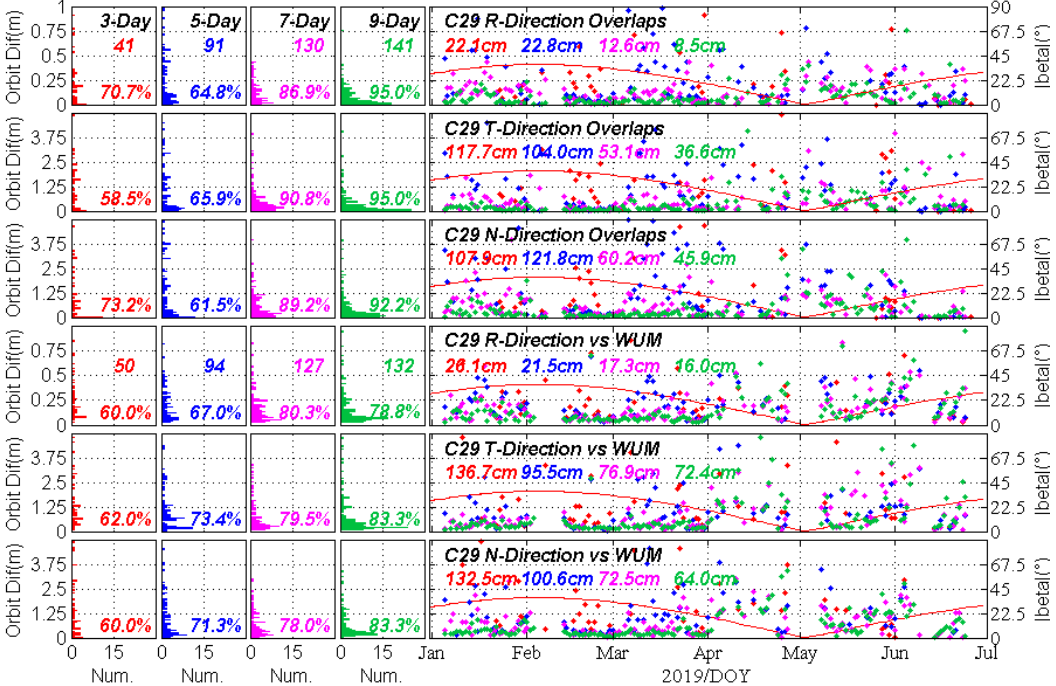
Figure 13. The results of SLR-only orbit determination for C29.